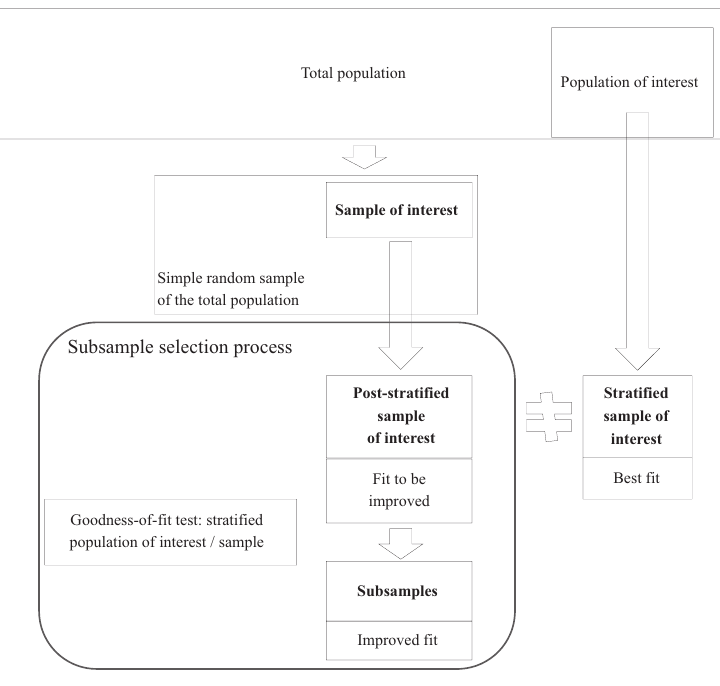
Figure 1. Graphical illustration of the